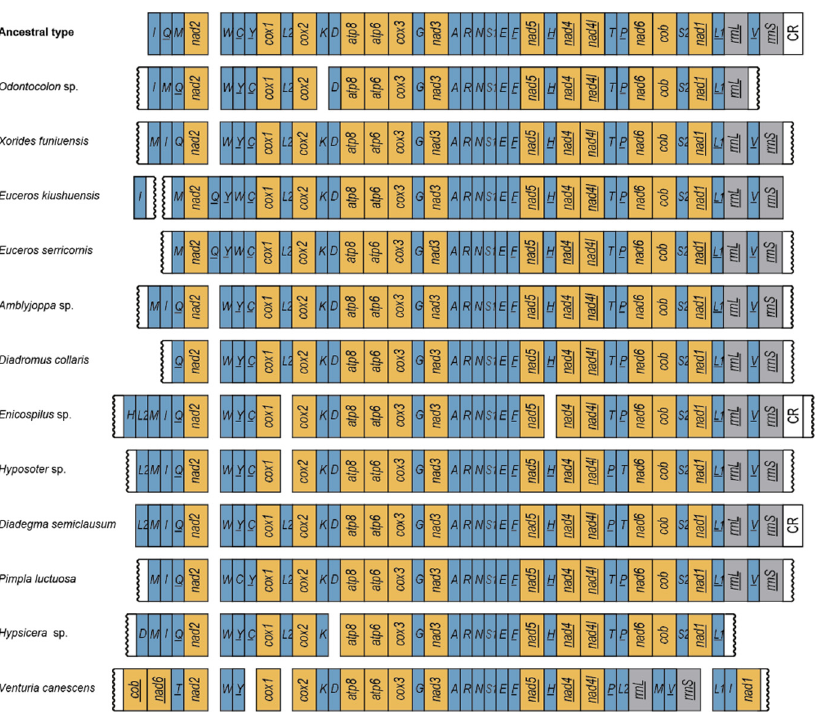
Figure 2. Synonymous (Ka) and non-synonymous substitutional (Ks) rates and the ratios of Ka/Ks of 13 protein coding genes (PCGs) in mitochondrial genomes of all sequenced species in Ichneumonidae. JKa, JKs and JKa/JKs are the values corrected by the Jukes–Cantor correction (Jukes and Cantor, 1969).